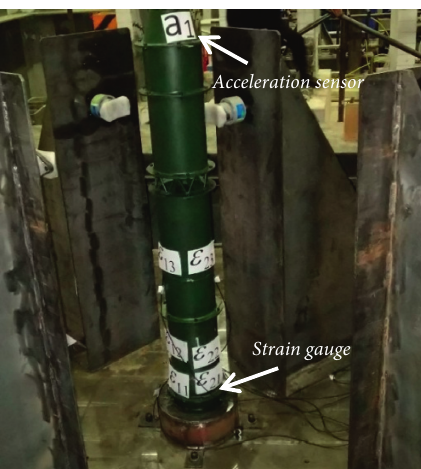
Figure 18: The scaled-down model of the four-stage storage tank.